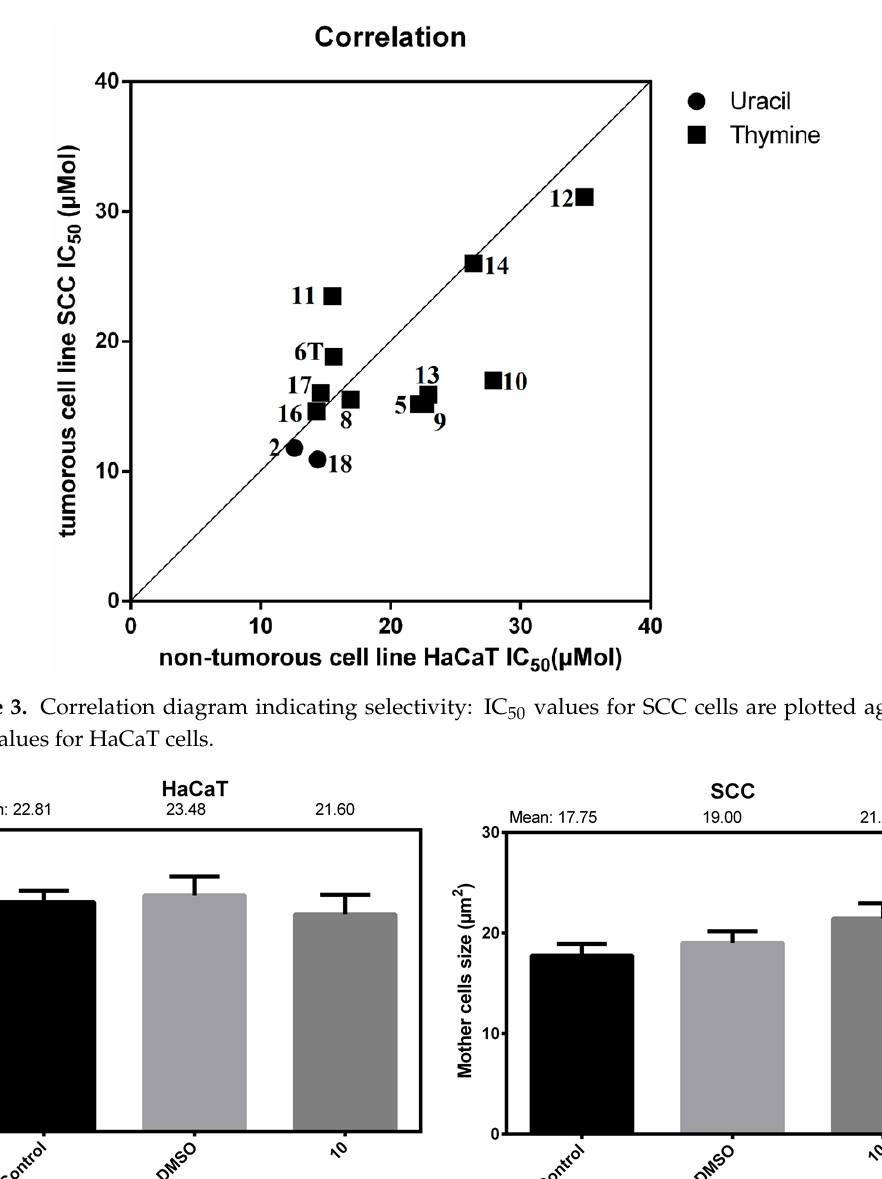
Table 5. The effect of compound 10 on the generation times of the cells. Control Gen. Time (h)